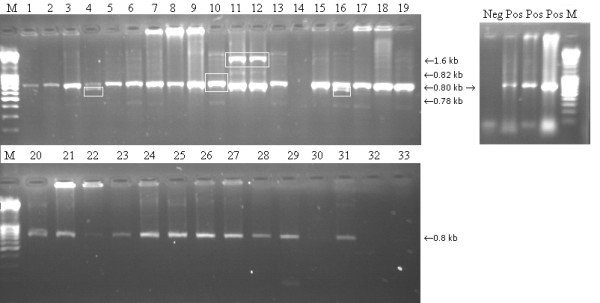
PCR for the detection of reticuloendotheliosis virus (REV) long terminal repeats. M-Mass Ruller 100 kb Plus (80 base pairs - 10,000 base pairs), Fermentas, Neg- negative DNA control extracted from non-infected chicken embryo kidney cells, Pos - replicates of DNA control extracted from the infected chicken embryo kidney cell cultures with REV-T strain 5 days post inoculation. All three positives are derived from the same original strain. 1 - 23_07_PL, 2 - 25_07_PL, 3 - 29_07_PL, 4 - 30_07_PL, 5 - 31_07_PL, 6 - 32_07_PL, 7 - 2_08_PL, 8 - 3_08_PL, 9 - 7_08_PL, 10 - 8_08_PL, 11 - 45_08_PL, 12 - 48_08_PL, 13 - 56_08_PL, 14 - 73_08_PL, 15 - 8_09_PL, 16 - 23_09_PL, 17 - 26_09_PL, 18 - 40_09_PL, 19 - 42_09_PL, 20 - 45_09_PL, 21 - 51_09_PL, 22 - 81_09_PL, 23 - 82_09_PL, 24 - 86_09_PL, 25 - 8_10_PL, 26 - 10_10_PL, 27 - 11_10_PL, 28 - 30_10_PL, 29 - 61_10_PL, 30 - BAC_31_07Δmeq, 31 - BAC_7_08, 32 - HPRS16, 33 - Rispens, random insertions into Marek's disease virus genomes are marked with white boxes.